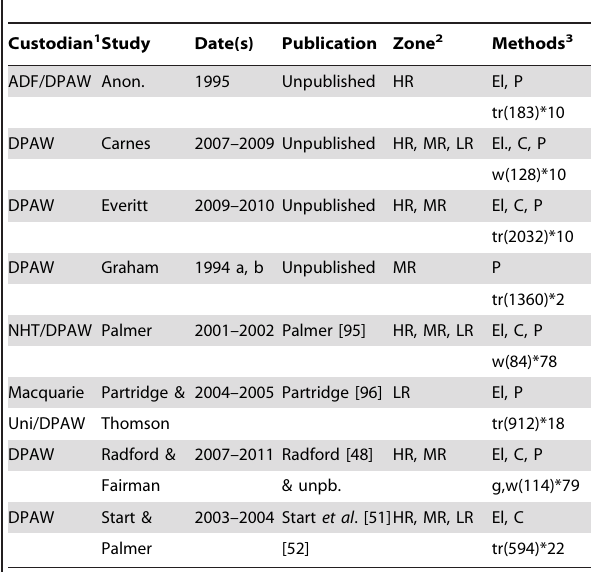
Table 1. Data custodians, dates, publication details, Kimberley zones trapped and methods used to obtain survey data included in this